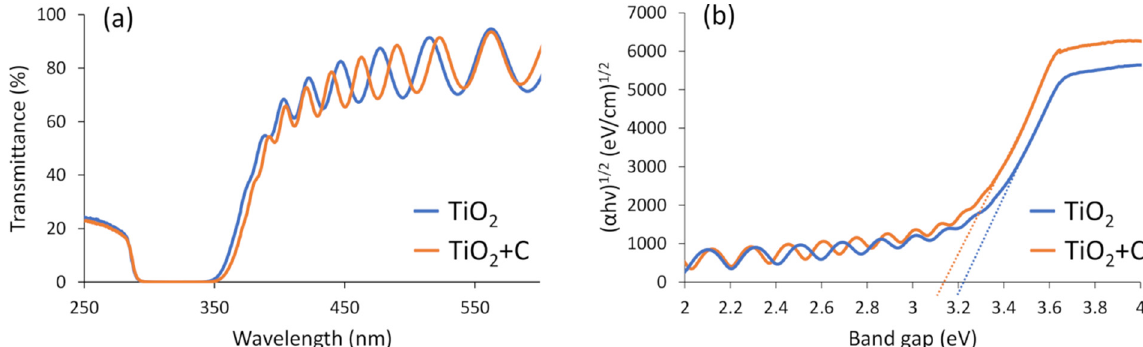
Figure 4. Transmittance ( a ) and band gap ( b ) spectra of pure TiO 2 and C-doped TiO 2 films deposited on borosilicate glass substrates.